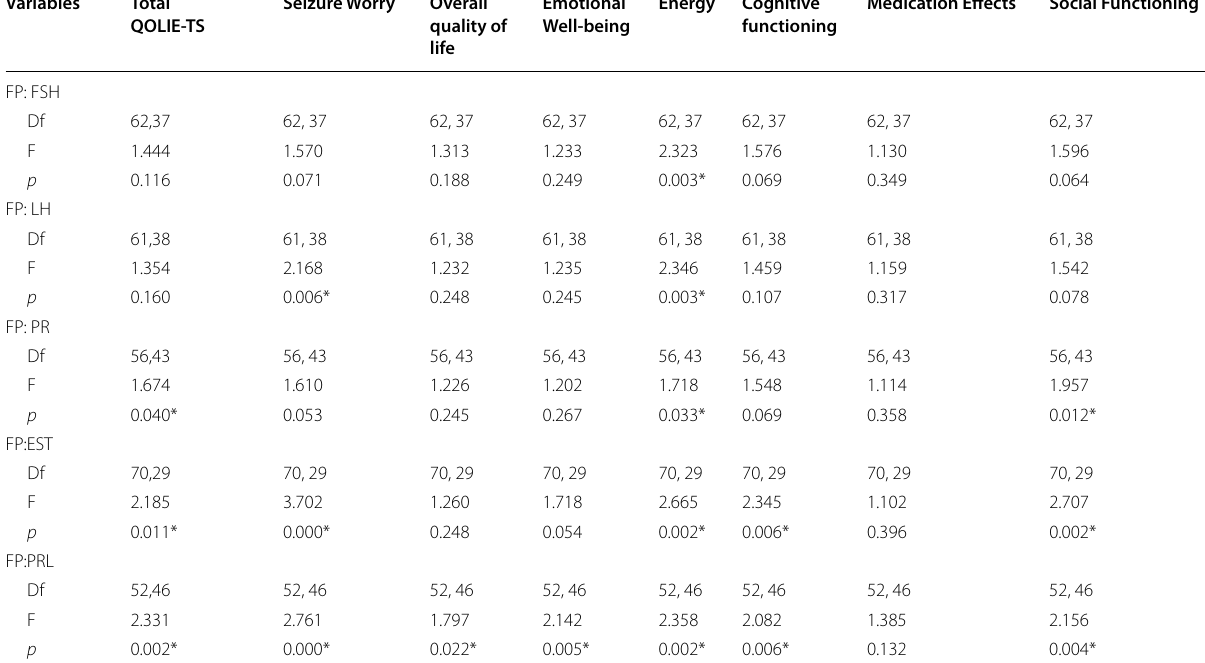
Table 6 Relationship between hormones and QOLIE‑31